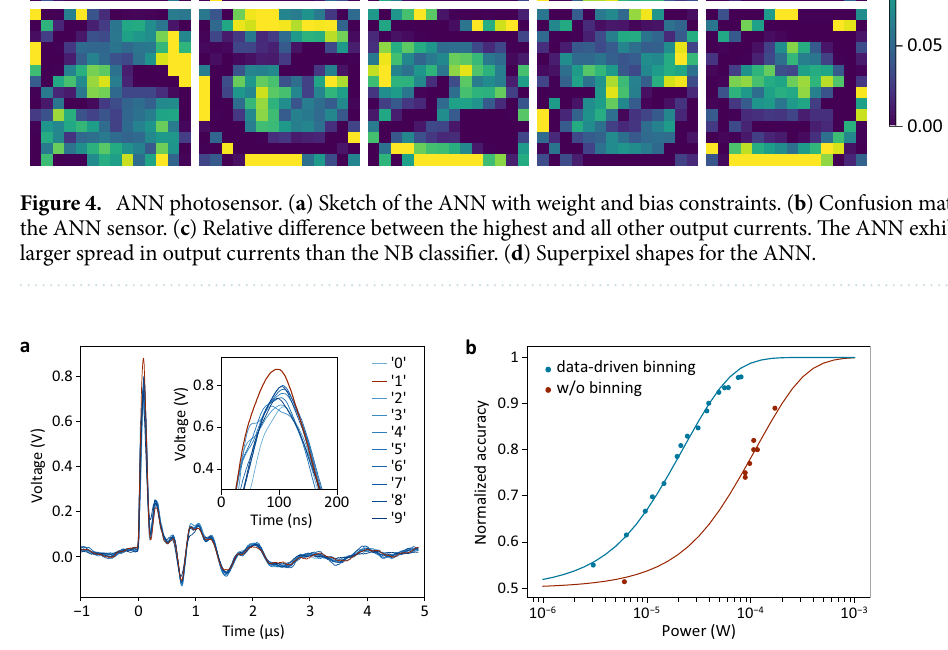
Figure 5. Evaluation of the device performance. ( a ) Demonstration of the high-speed capabilities of the sensor, measured with a 40-ns pulsed laser source. A ‘1’ is projected onto the device and the currents of all superpixels of the NB classifier are recorded with an oscilloscope. The channel corresponding to the correct digit produces the highest output current. ( b ) Experimental (symbols) and calculated (lines) light-intensity dependent accuracies for the NB classifier (blue) and a reference device without binning